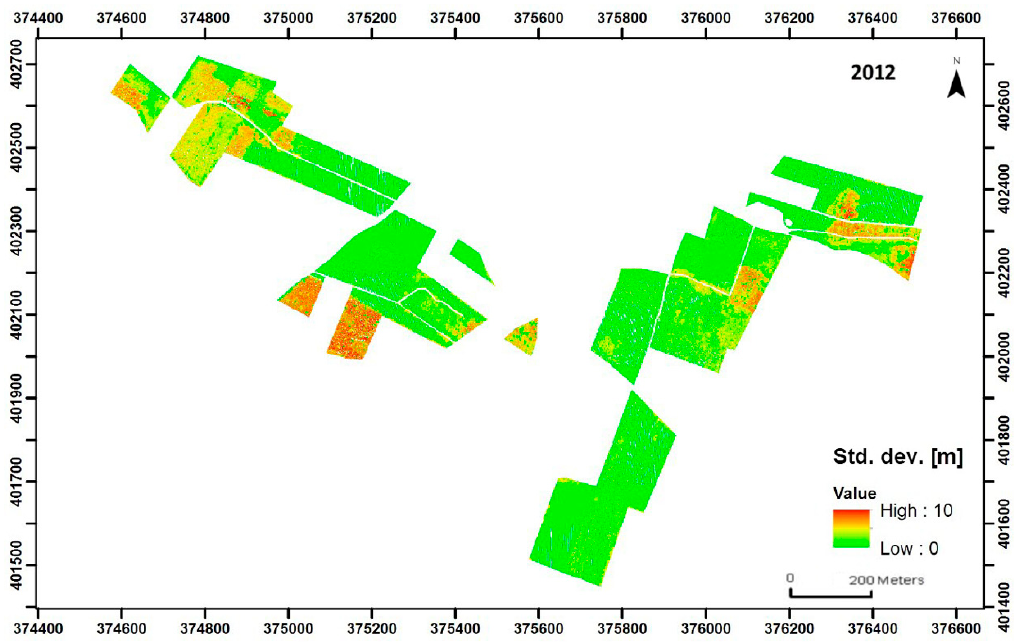
Figure 7. Vegetation parameters—standard deviation of height (SD, 2012 data).